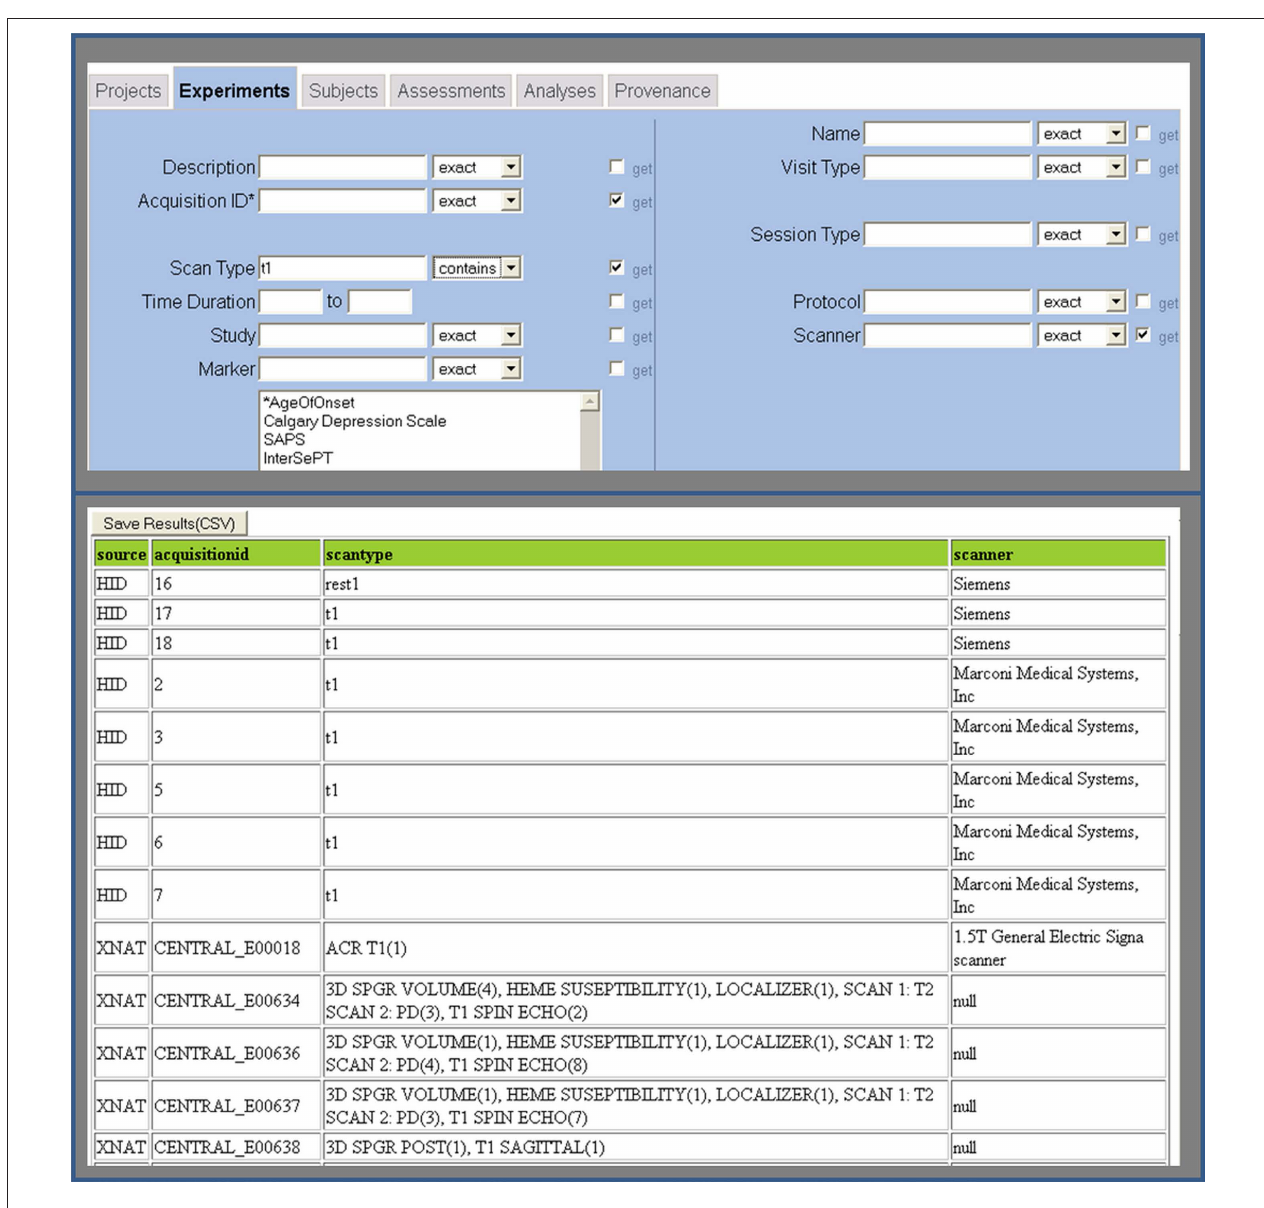
Figure 3 | FBirN query interface and